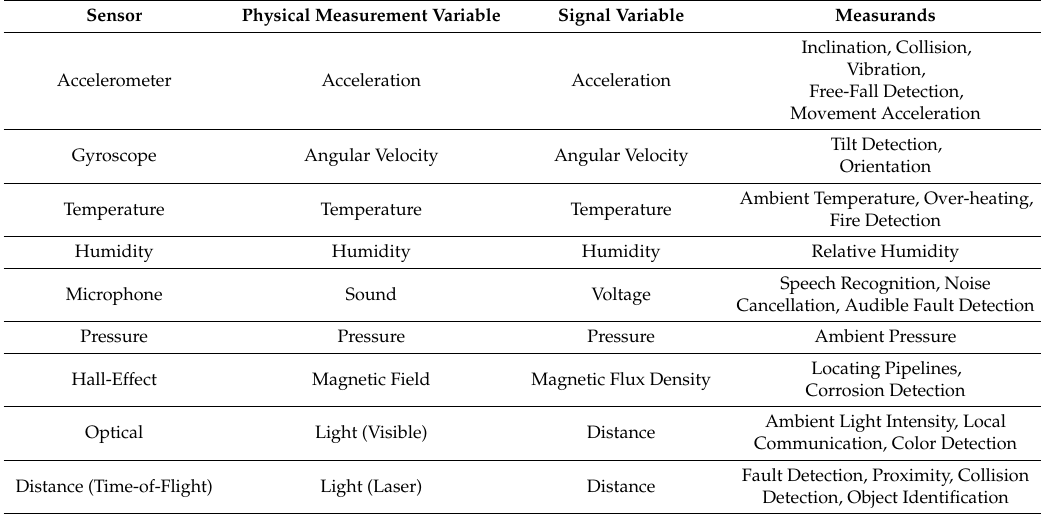
Table 1. The different physical measurements from each sensor on the Limpet and their relation to different possible